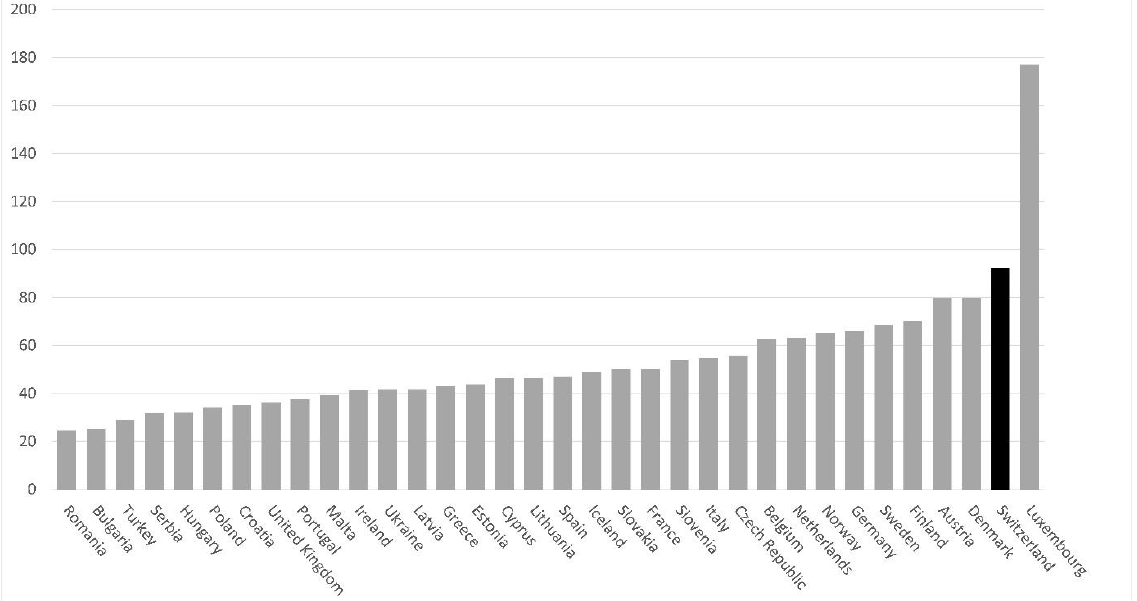
Figure 2: European countries ranked by index of affordability of tobacco products (vertical axis: number of 20-packs that can be purchased with 1% of GDP per capita). Source: WHO Report on the Global Tobacco Epidemic, 2015 [10].